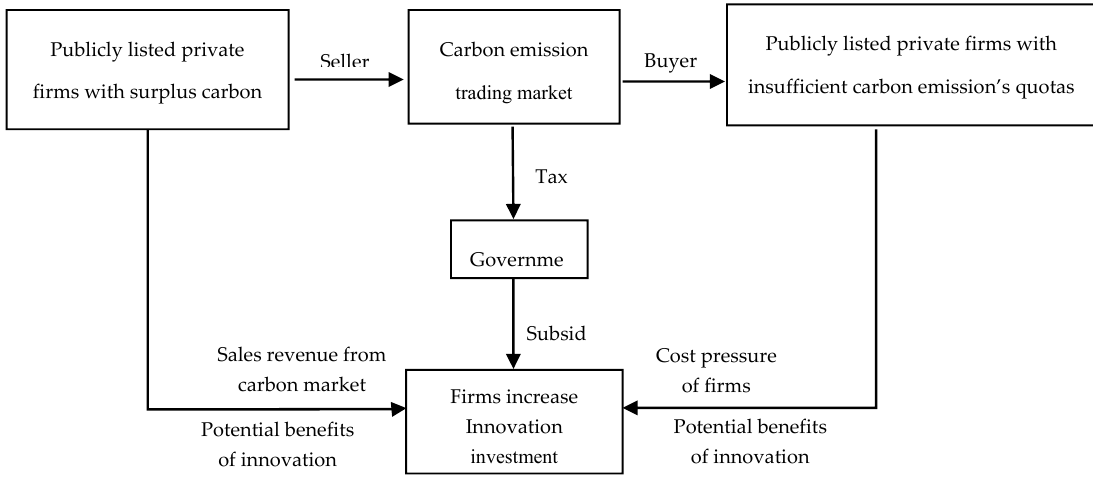
Figure 1. The influence mechanism through which CCETP affects the innovation input of publicly listed private firms.